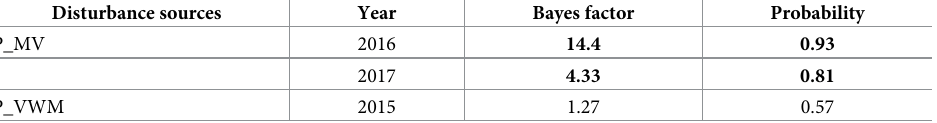
Table 4. Bayes factor for differences between the posterior means calculated for the duration of recovery, by dis- turbance source. Numbers in bold indicate credible differences. The probability that the first disturbance source was higher than the second one is also shown.